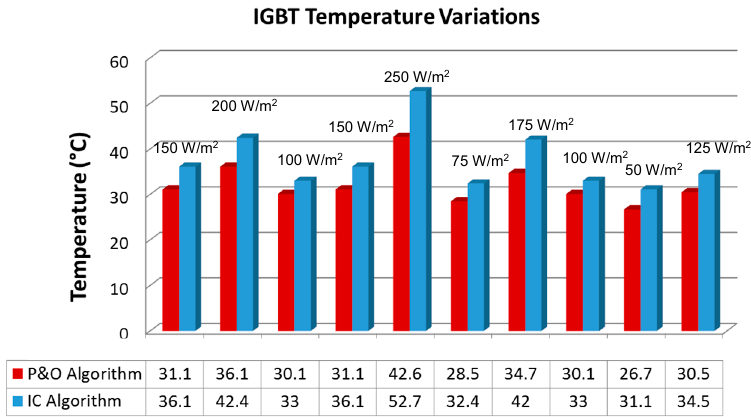
Figure 15. Steady state IGBT temperature comparisons when IC and P&O used as MPPT methods.